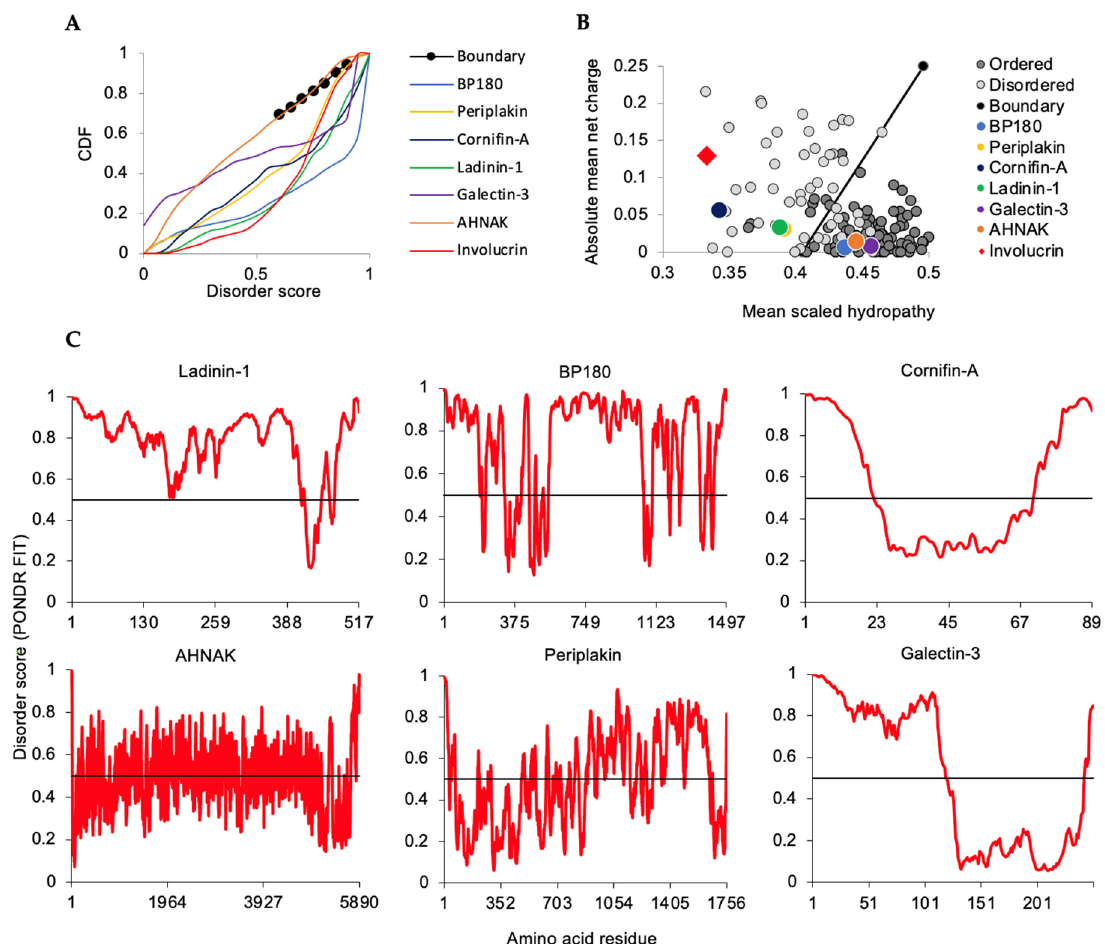
Figure 5. Intrinsic disorder analysis for thermostable proteins preferentially or specifically expressed in KCs. ( A ) Cumulative distribution function (CDF). Disordered proteins plot below database boundary (black line). ( B ) Charge-hydropathy boundary (black line) shows separation trend for database disordered (gray circles), ordered proteins (dark circles), and thermostable proteins. ( C ) PONDR-FIT analysis. Individual amino acids along the protein length scoring ≥ 0.5 reference value (black line) are in disordered regions. BP180, collagen type XVII alpha chain.